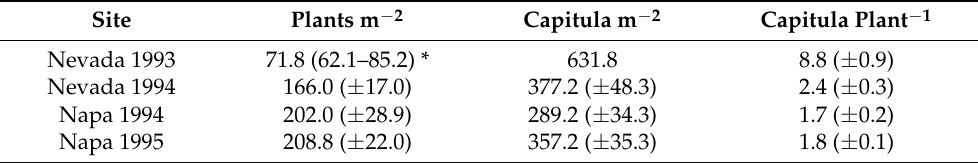
Table 2. Density and size (capitula/plant) of Centaurea solstitialis plants estimated from quadrat counts at two field sites for 1993–1995. For Nevada 1993, only density of plants was estimated so capitula per plant was obtained from plants sampled along transects and capitula per square meter was calculated by multiplying plants m − 2 by capitula per plant. Values reported are mean ( ± SE) except where noted.